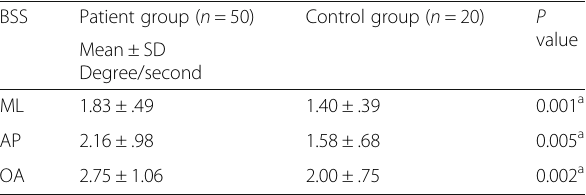
Table 2 Comparison between patient and control groups as regard the stability indices of BSS